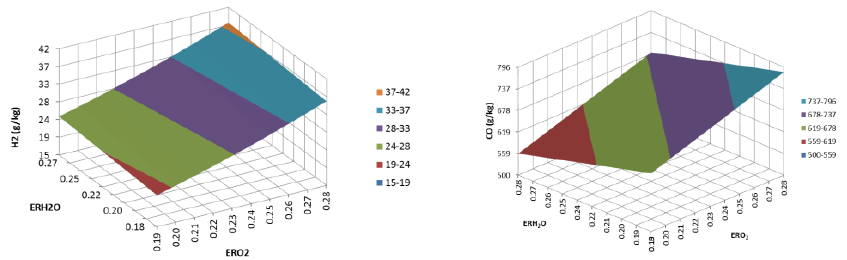
Figure 7. Yield of H 2 and CO as function of the equivalence ratio ER(O 2 ) and ER(H 2 O) for hazelnut shells.